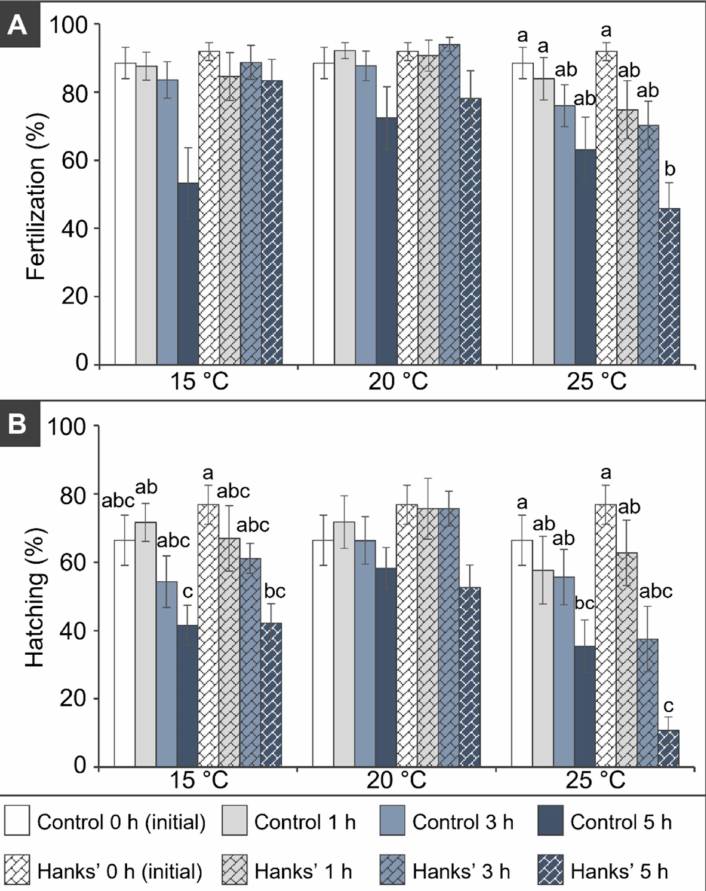
Figure 6. Developmental capacity after preservation of ovulated eggs of kawakawa Euthynnus affinis in different temperatures when compared between Hanks’ solution and control groups. ( A ) Fertiliza- tion rate and ( B ) hatching rate after the preservation of ovulated eggs in Hanks’ solution and without artificial medium (control) for 0, 1, 3, and 5 h at 15 ◦ C, 20 ◦ C, and 25 ◦ C. Different superscript letters indicate significant differences determined by the Steel–Dwass test ( p <